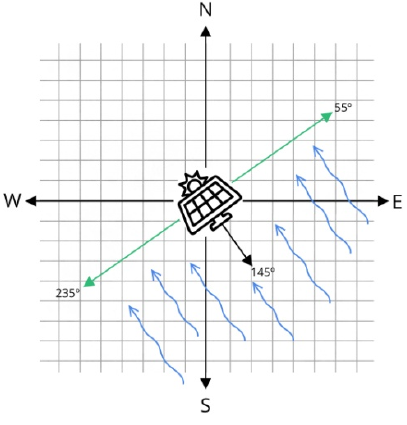
Figure 3. ESTIA1 PV panels orientation.